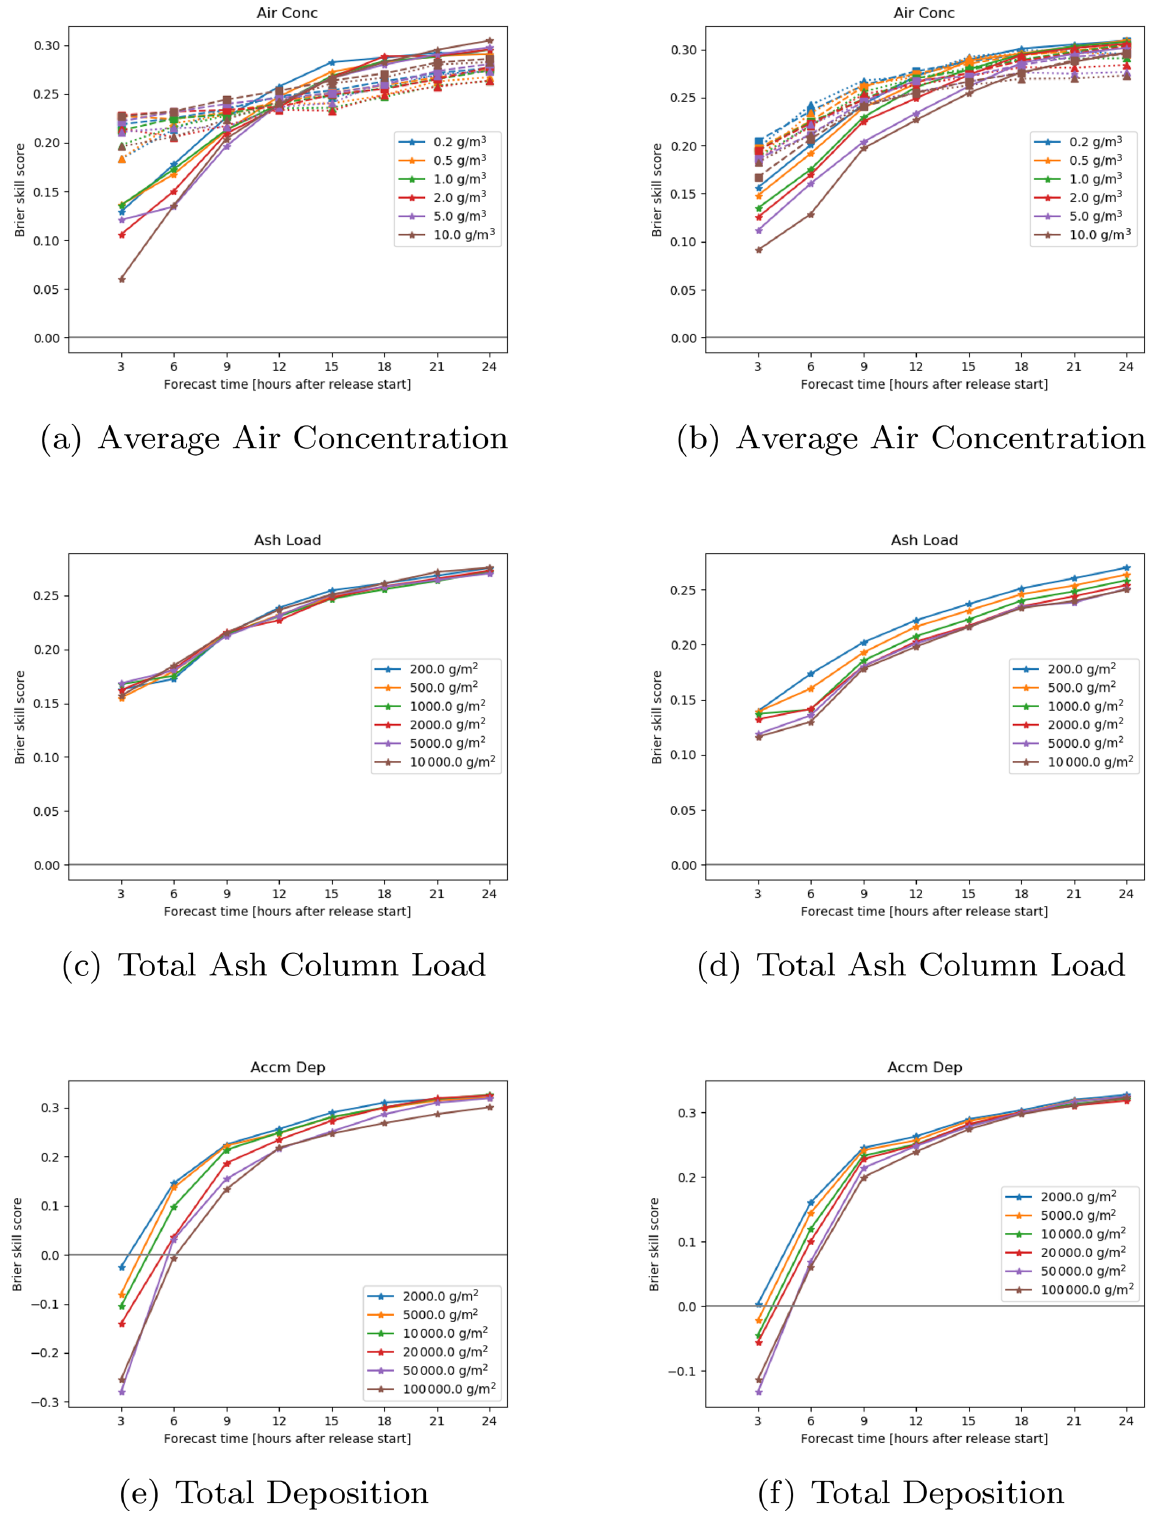
Figure 6. Brier skill score against forecast time (hours since the start of the eruption) for (a, b) ash concentration on three flight levels (solid lines are FL000-200, dashed lines are FL200-350, and dotted lines are FL350-550), (c, d) ash column load, and (e, f) accumulated deposition for five different thresholds. The left-hand-side column is for a 12km eruption of Hekla and the right-hand-side column is for a 25km eruption of